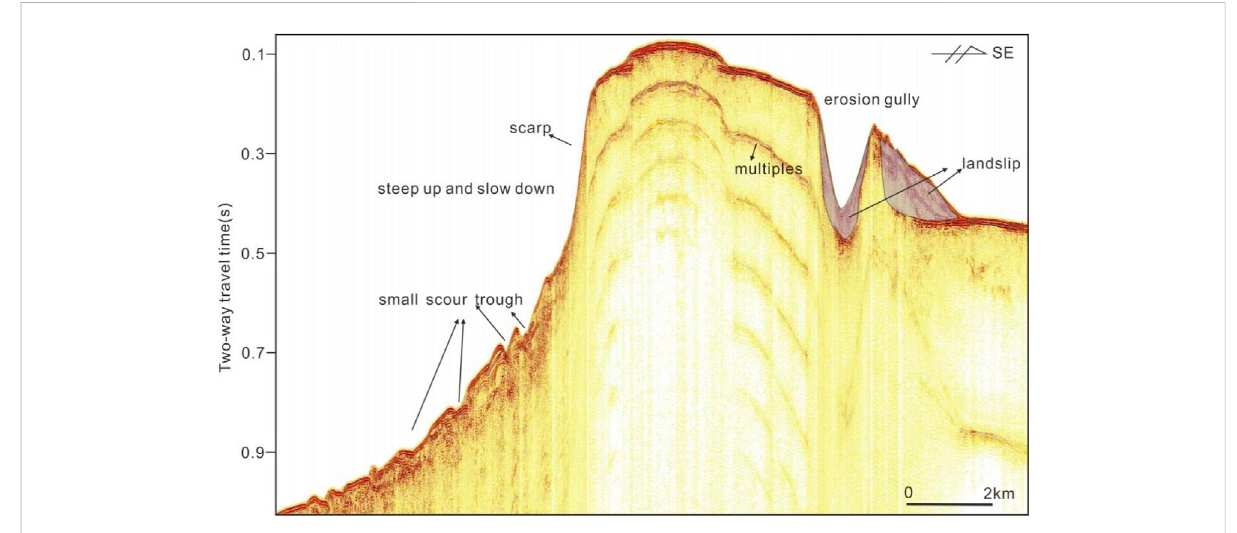
FIGURE 8 Scour trough phenomenon re fl ected on a single earthquake.